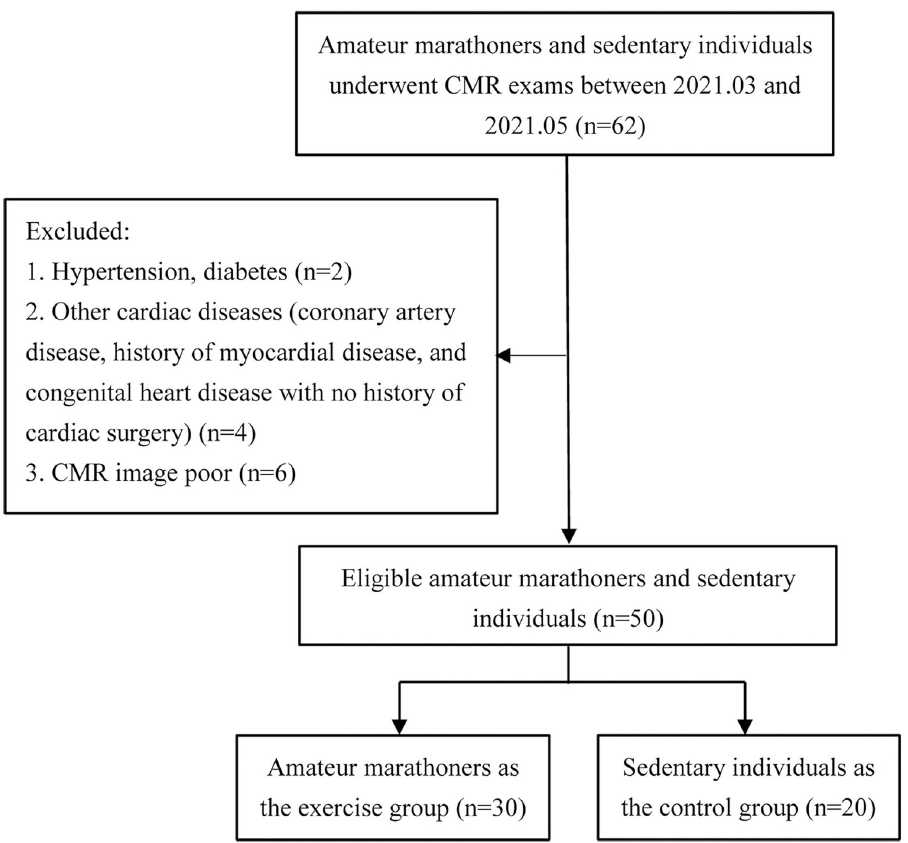
Fig 1. Flow diagram showing the selection and group of Amateur marathoners and sedentary individuals. CMR, cardiac magnetic resonance.